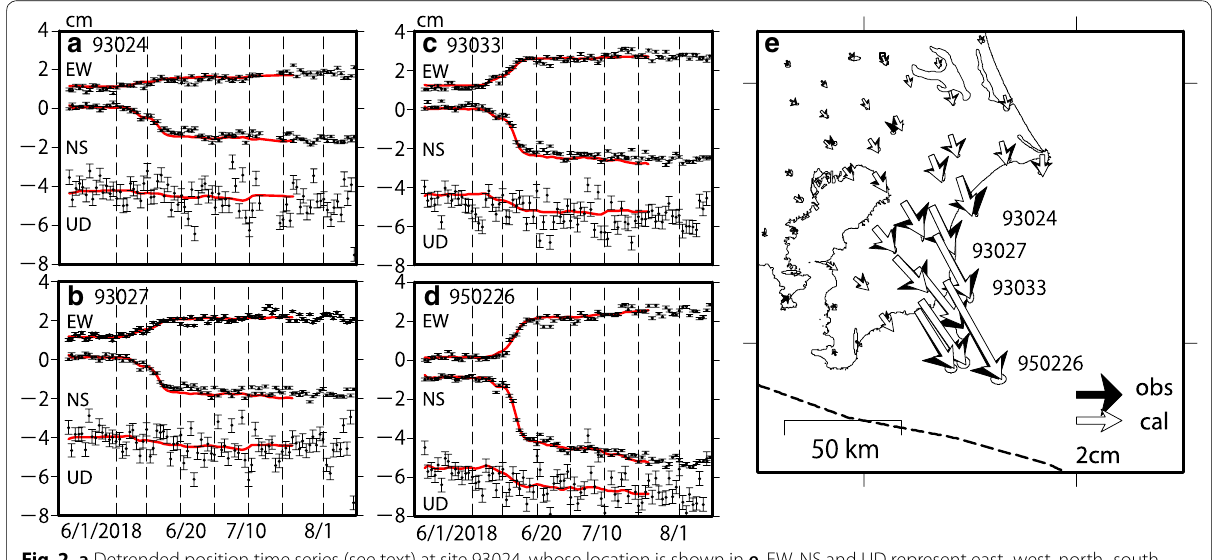
Fig. 2 a Detrended position time series (see text) at site 93024, whose location is shown in e . EW, NS and UD represent east–west, north–south and up–down components, with eastward, northward and upward positive, respectively. Red lines show values computed by our best-fitting interplate aseismic slip model. Error bars show one standard deviation estimated from time-dependent inversion. b – d Detrended position time series at various sites. b 93027, c 93033, d 950226. e Total southeastward transient for the 2018 SSE. Black arrows indicate horizontal detrended displacements for the period between June 1 and July 23, while white arrows indicate values computed by our best-fitting aseismic model. Error ellipses show one standard deviation estimated from ordinary Kalman filtering (see